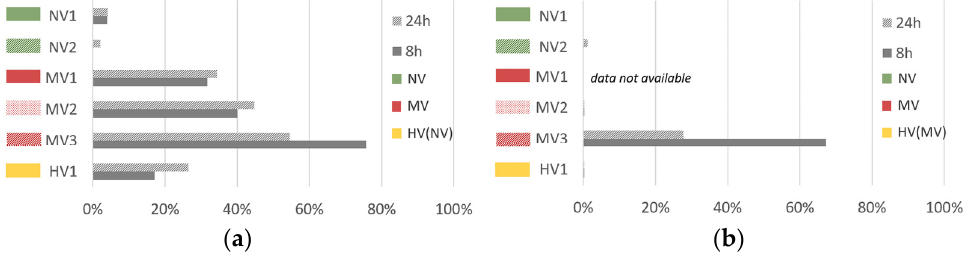
Figure 5. Share of cycles with an open window: ( a ) summer–autumn; ( b ) winter.